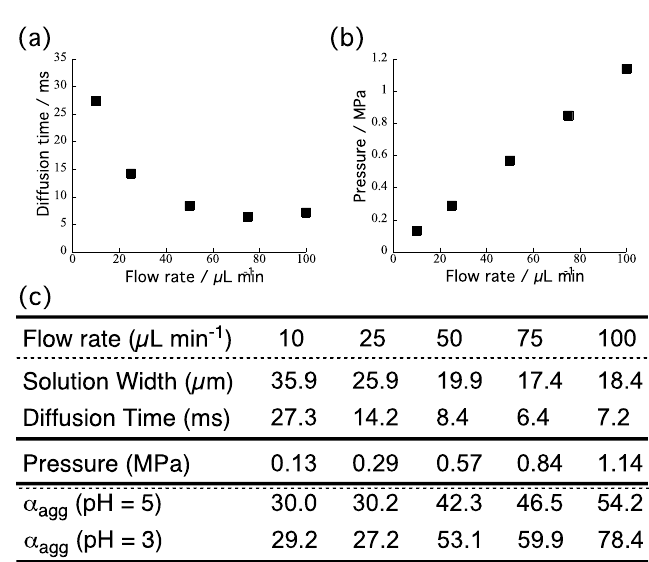
Figure 4. ( a , b ) Plots of ( a ) diffusion time of proton and ( b ) measured pressure against the flow rate in the channel. ( c ) Total aggregation efficiencies ( α agg ) obtained upon changing the flow rate (for the plot, see Figure S1).